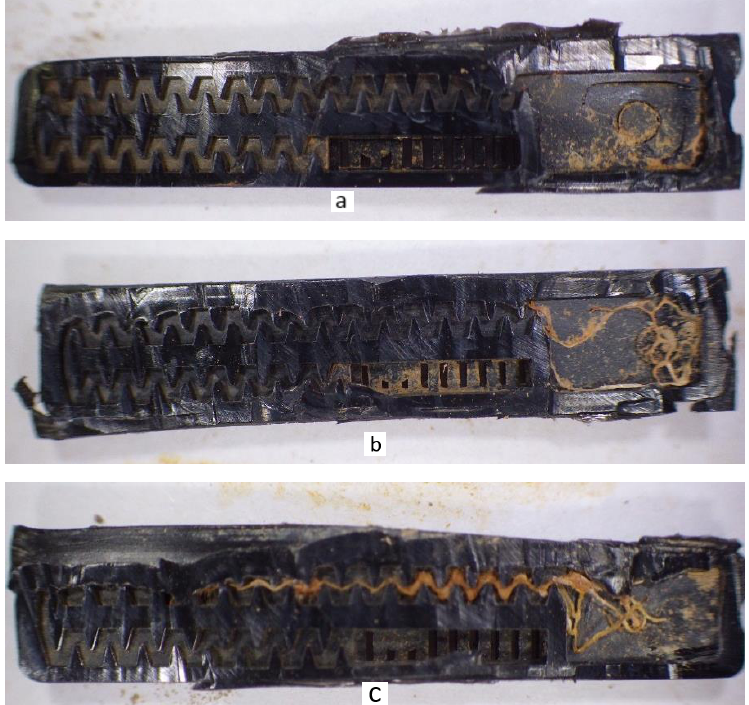
Figure 12. Photos of anatomical emitters: ( a ) no root intrusion; ( b ) roots that had entered into the water outlet of the emitter but had not entered into the channel; ( c ) roots that had entered into the emitter channel.